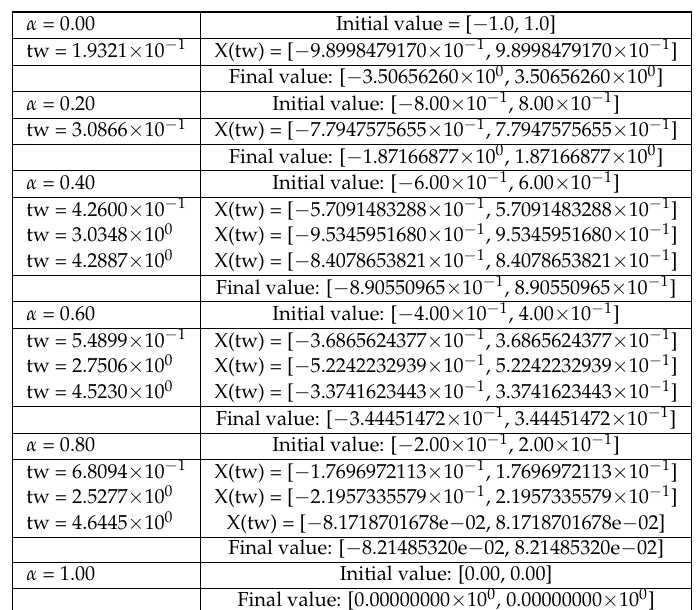
Table 4. (Interval-valued problem IDE2-b): For five values of α ∈ { 0,0.2,0.4,0.6,0.8 } , the switching points tw corresponding to Meth=2 are given in the first column; the second column contains the interval-valued solution X ( tw ) = [ x − α ( tw ) , x + α ( tw )] . The number of switching points changes with α and if α = 1, the solution is single-valued and no switching point